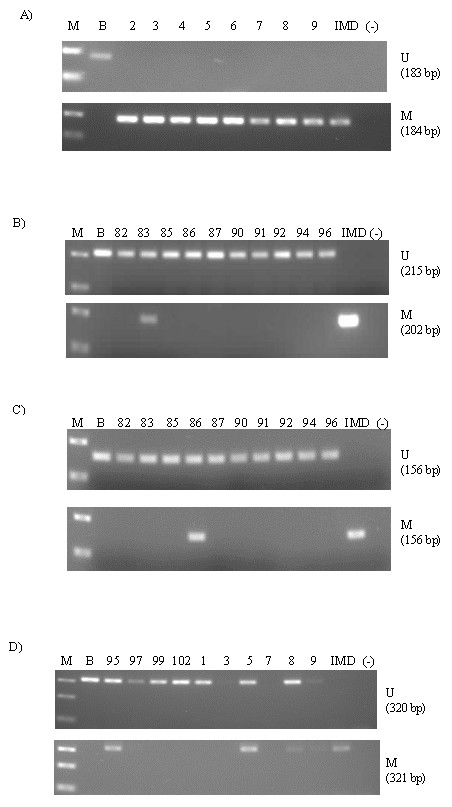
Promoter methylation analysis of RASSF1A (A), NORE1A (B), BLU (C) and CASP8 (D) in neuroblastic tumors (B, C and D) and cell lines (A), determined by MSP and visualized in 2.5% agarose gels stained with 0.1 μg/ml ethidium bromide. U/M: unmethylated/methylated; M: 1 Kb Plus DNA Ladder (Invitrogen™ Life and Technologies, Carlsbad, CA, USA); B: DNA obtained from blood of a normal donor; IMD (in vitro methylated DNA): positive control, CpGenome™ Universal Methylated DNA (Chemicon International, Inc., Temecula, CA, USA);-: water (no DNA negative control). A) 2: SH-SY5Y; 3: SK-N-SH; 4: SK-N-MC; 5: IMR-32; 6: MHH-NB-11; 7: SK-N-Be(2); 8: SK-N-DZ; 9: BE(2)C. B), C), and D) Numbers on top of each well correspond to DNA from different neuroblastic tumors analyzed.